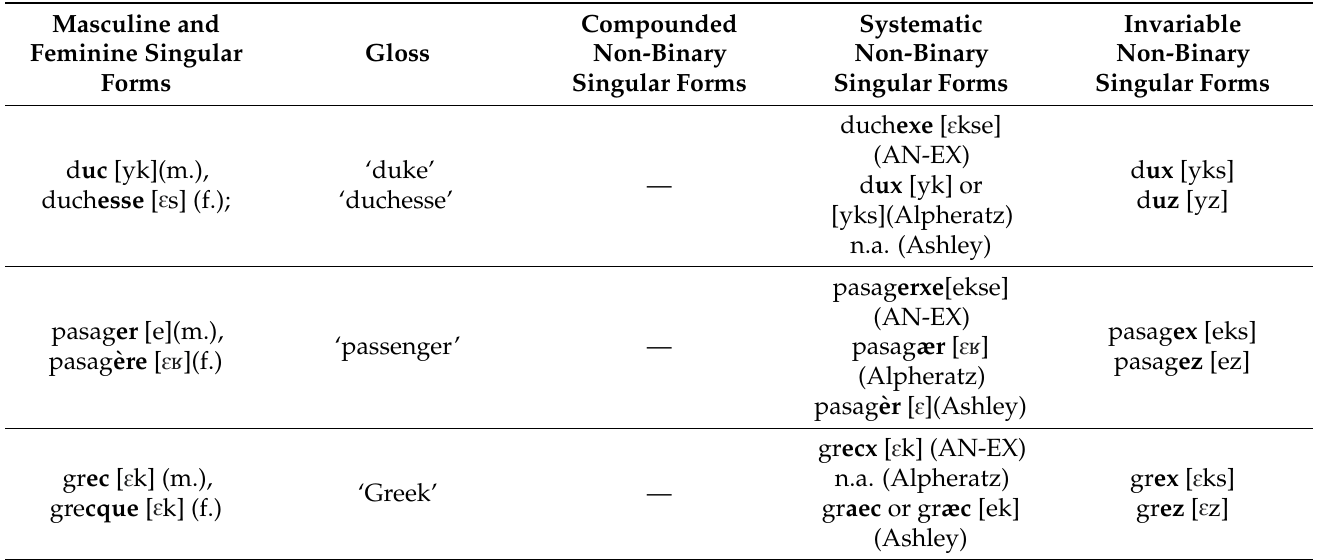
Table A1. Cont. Table 2. Masculine and Feminine Homophones. Feminine Masculine